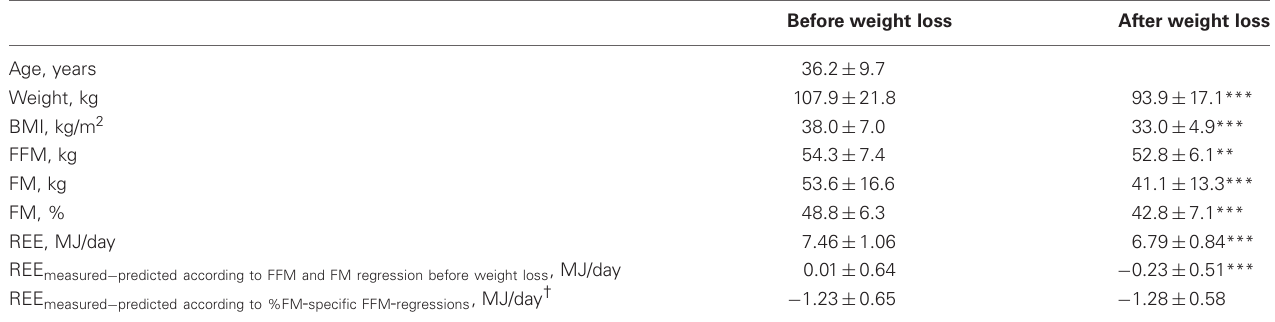
Table 5 | Comparison of body composition and resting energy expenditure between baseline and after weight loss ( n = 110 females, study population 3 without organ-tissue analysis).